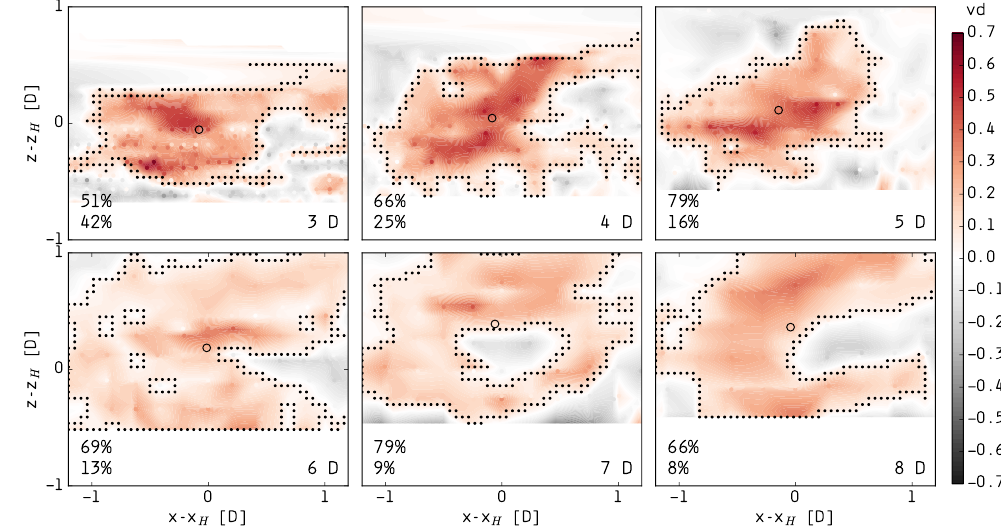
Figure 9. Velocity deficit for a 3D scan from field measurements (shaded dots) and linear interpolation onto a regular grid (shaded contours) in the vertical ( z ) and cross-stream ( x ) directions at discrete distances downstream of the turbine from 3 D–8 D. Wake shape (black dots) and center (circle). Wind direction offset for this scan is ∆ β ∼ 7 ◦ . Percent values given in each frame are SGC (top) and SGD (bottom) in